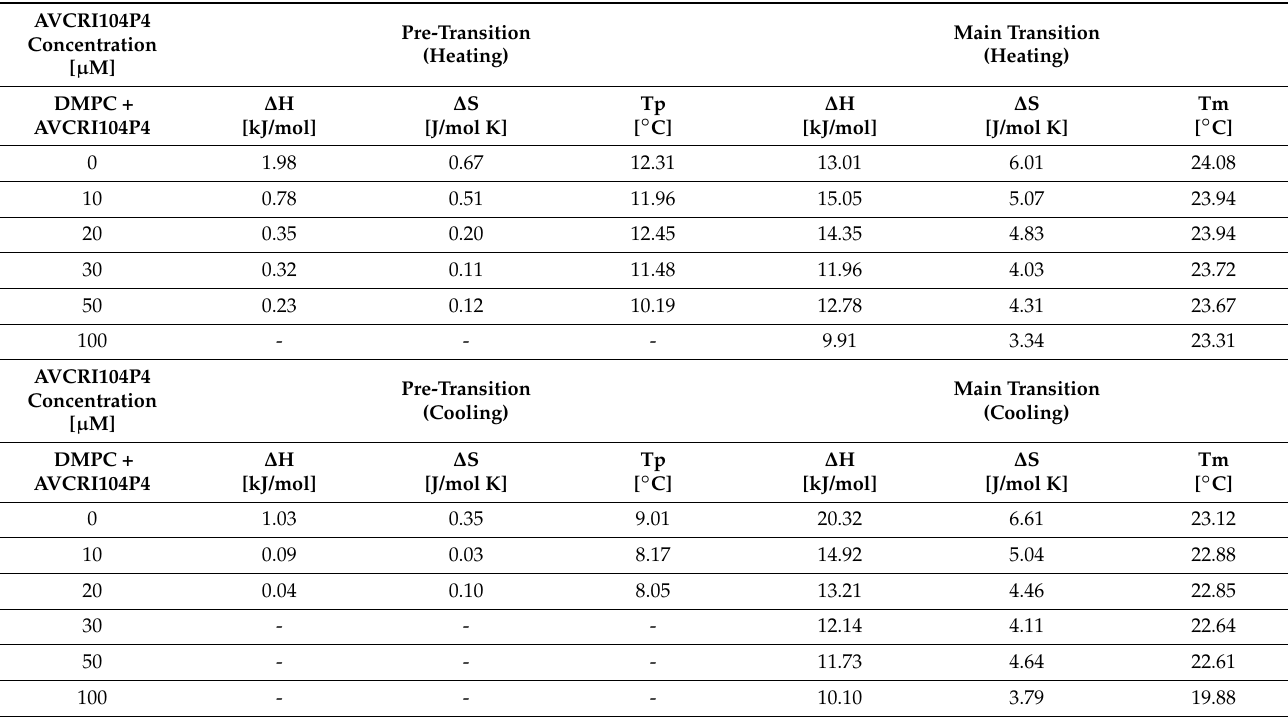
Table 4. Thermodynamic parameters of pre-transition and main phase transition of pure, fully hydrated, multilamellar liposomes and mixtures of DMPC/AVCRI104P4 obtained from heating and cooling; scans collected at a rate of 1 ◦ C min − 1 for both processes. The accuracy of the main phase transition temperature and enthalpy was ± 0.01 ◦ C and ± 0.8 kJ/mol, respectively. AVCRI104P4